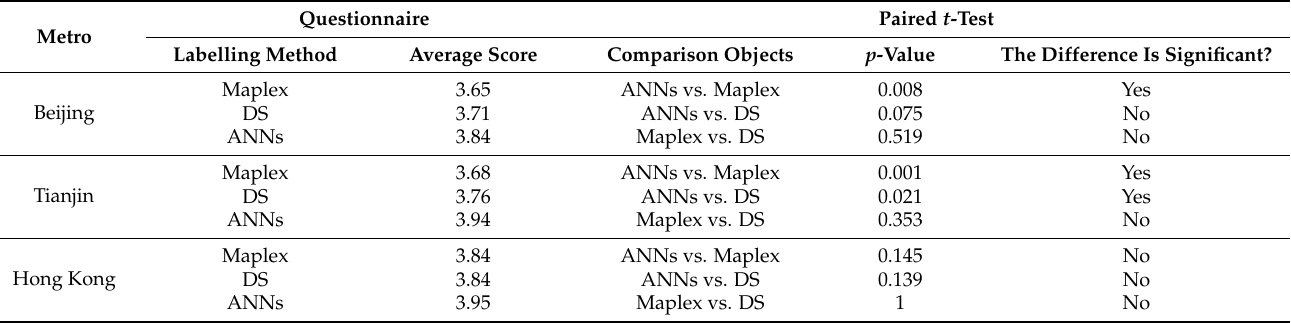
Table 3. Average scores and paired t -test results in the